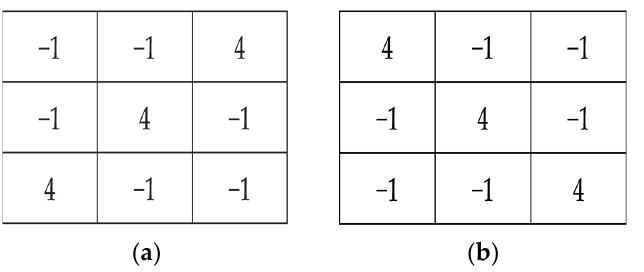
Figure 4. Detection results of two direction detectors. ( a ) 45” lane line detector, and ( b ) 135” lane line detector.